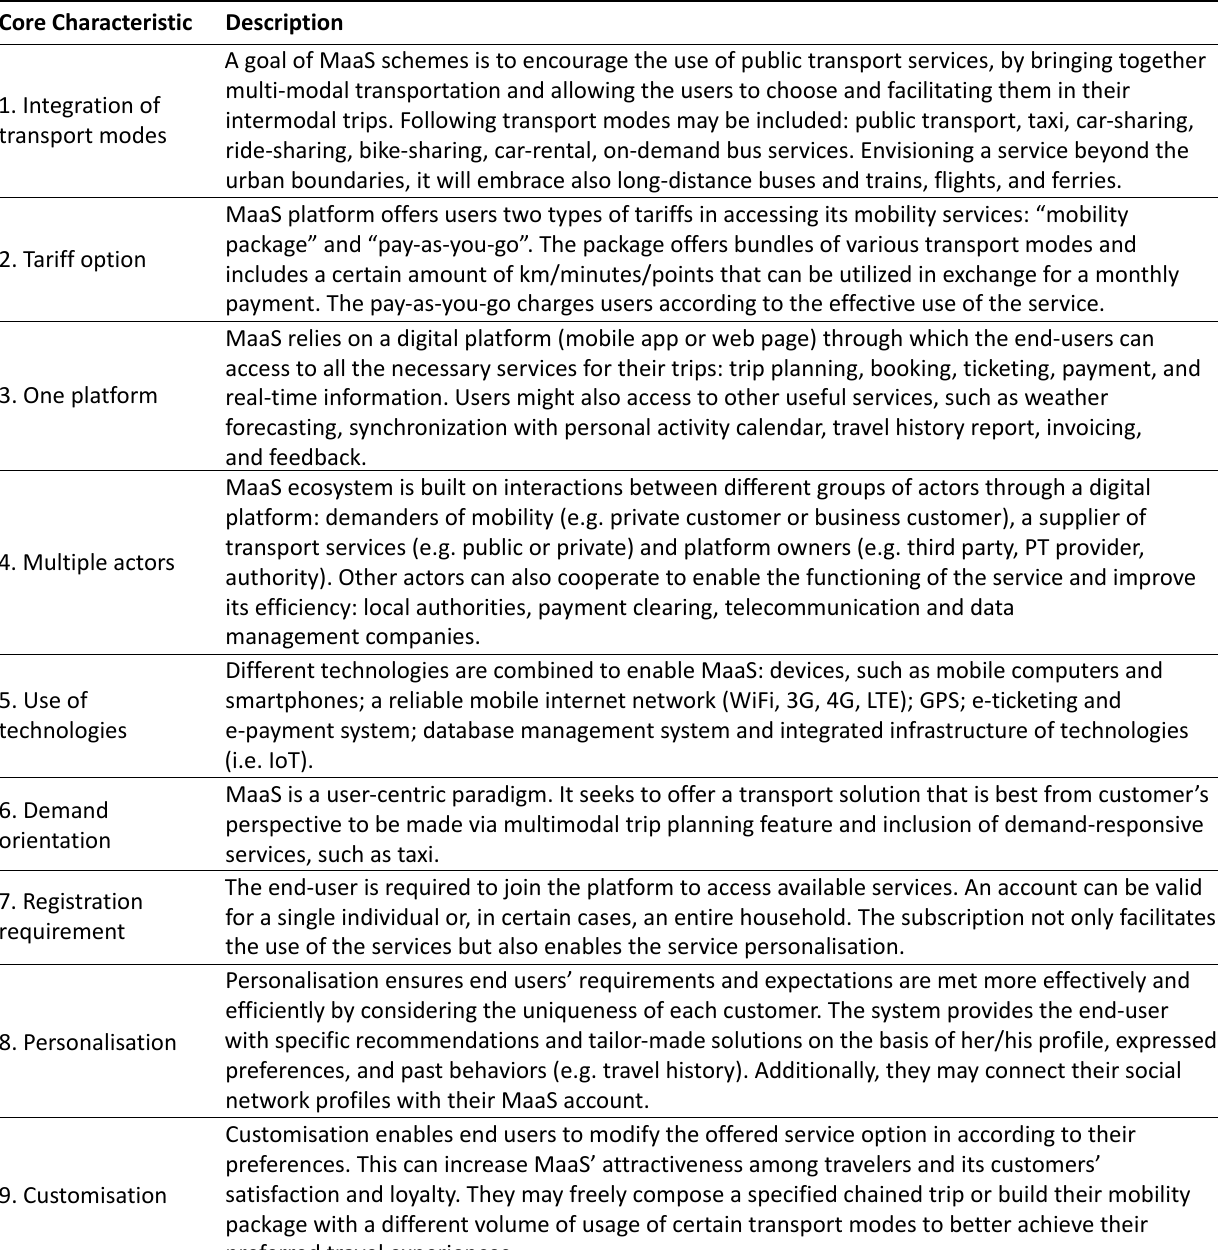
Table 1. Description of MaaS’ core characteristics based on literature